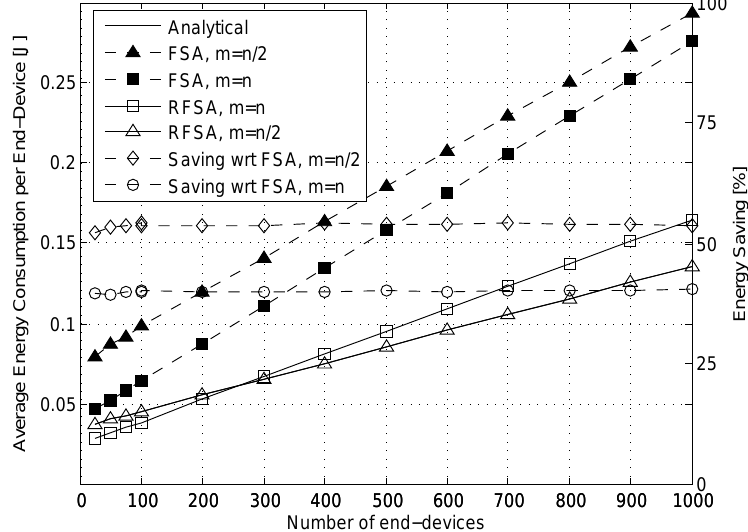
Figure 7. Average energy consumed (left vertical axis) per end-device in a data collection round using m = n and m = n/ 2 slots per frame. The energy savings provided by RFSA with respect to FSA is shown in the right vertical